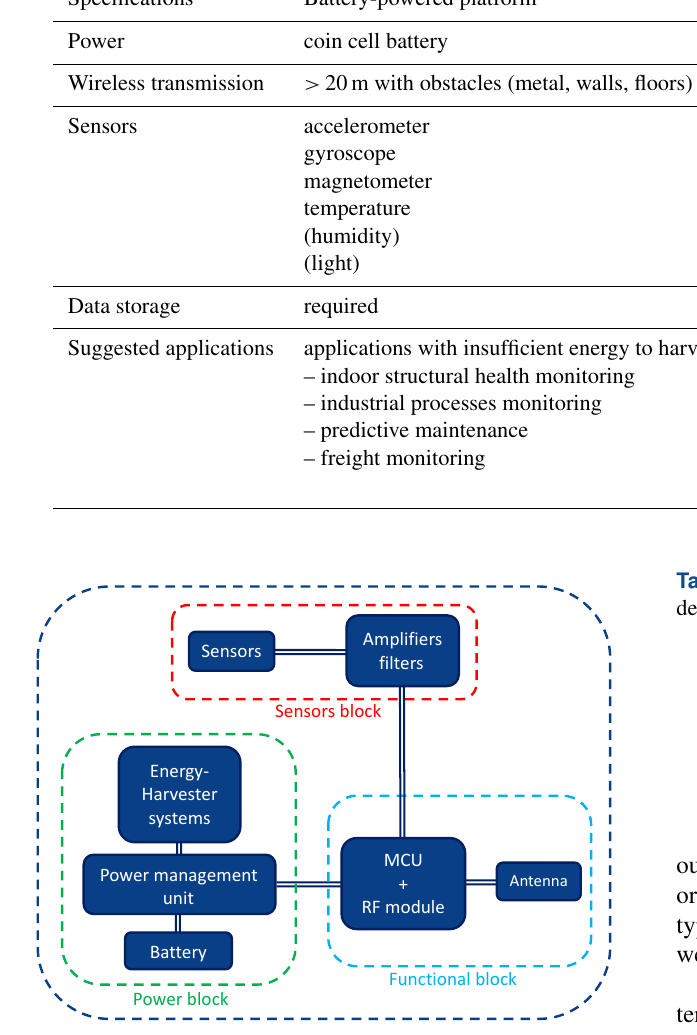
Figure 1. Block diagram of the platform.